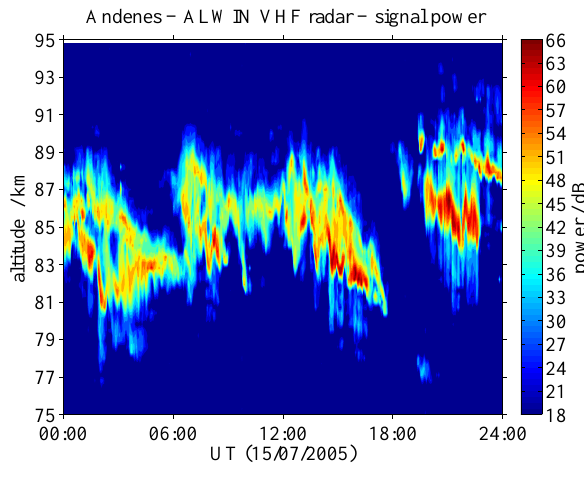
Fig. 1. Relative signal power of Polar Mesosphere Summer Echoes observed on 15 July 2005 with the ALWIN MST radar at